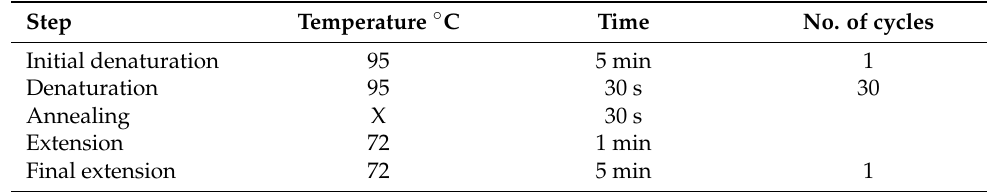
Table 1. Conditions of the PCR. (X: annealing temperature was adjusted according to the melting temperature of the used primers).